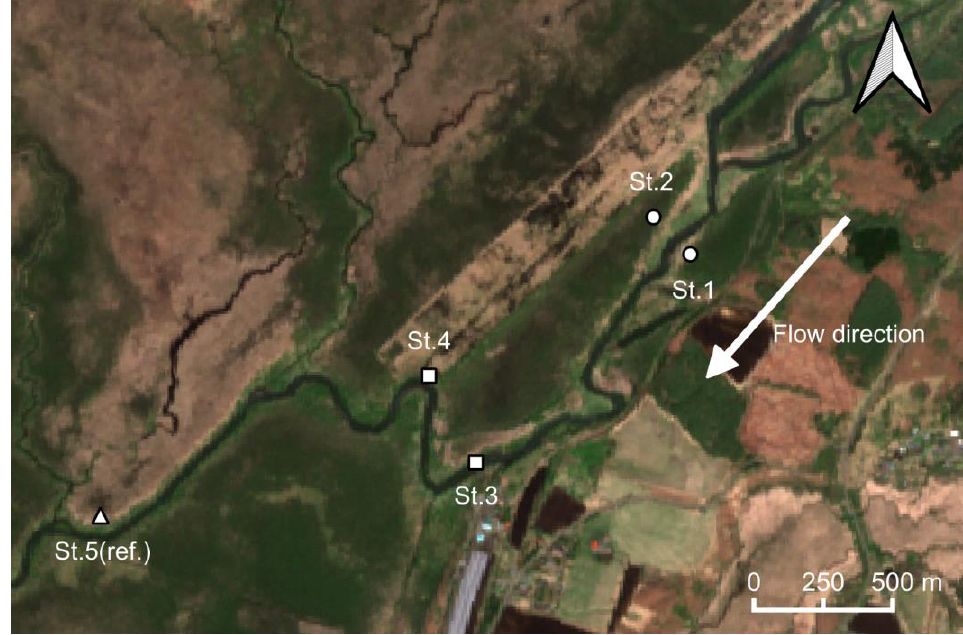
Figure 2. Historical changes in the study site of Kushiro Wetland from aerial images. These aerial images cover 2 km square centered at 43°12 ′ N, 144°30 ′ E (( a ): 15 October 1948, ( b ): 24 September 2005, Source: modified from the image in Geospatial Information Authority of Japan [55]), (( c ): 19 May 2021, Source: modified from the image in Google Earth Engine [56]).